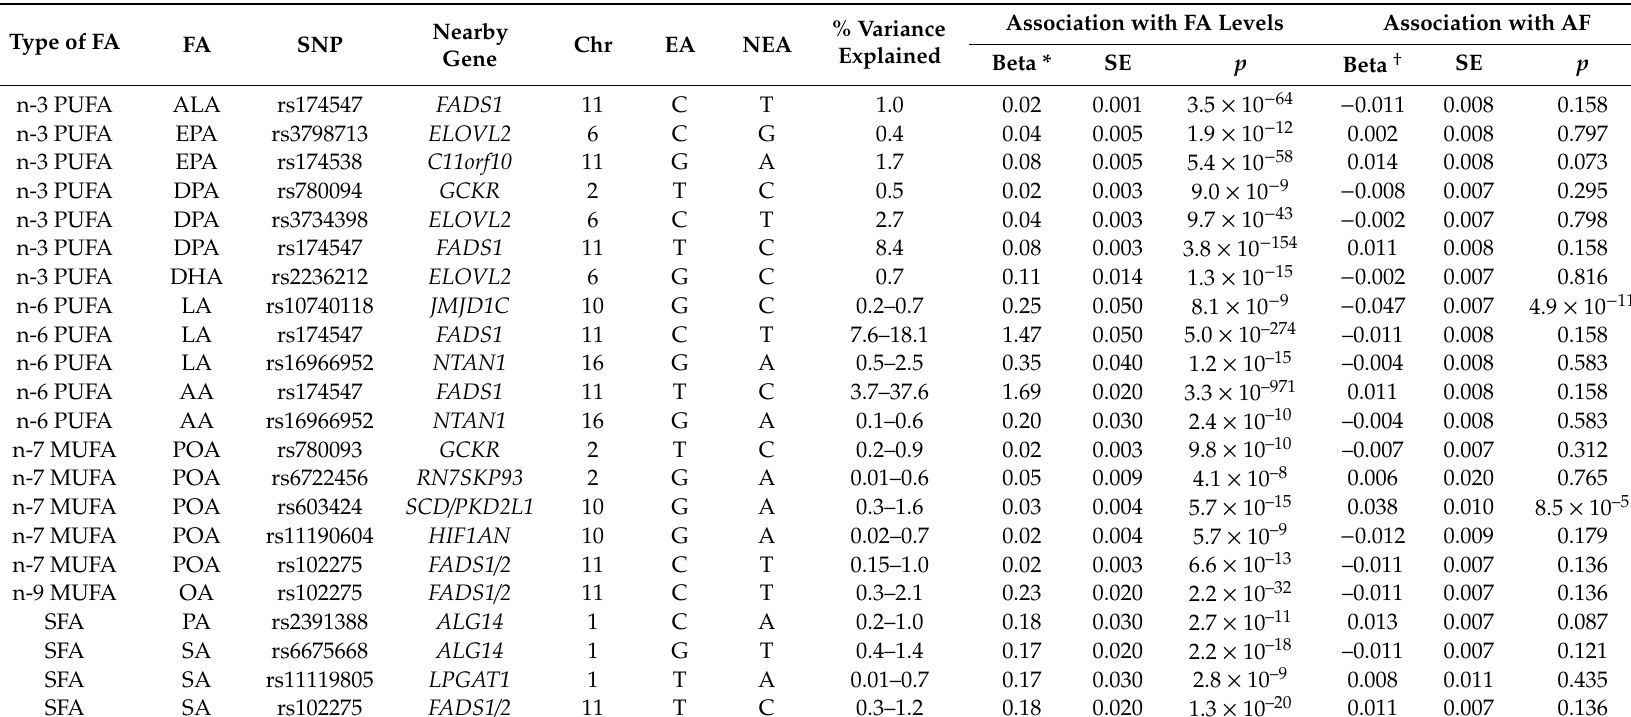
Table 1. Characteristics of the single-nucleotide polymorphisms (SNPs) associated with plasma FA levels and their associations with atrial